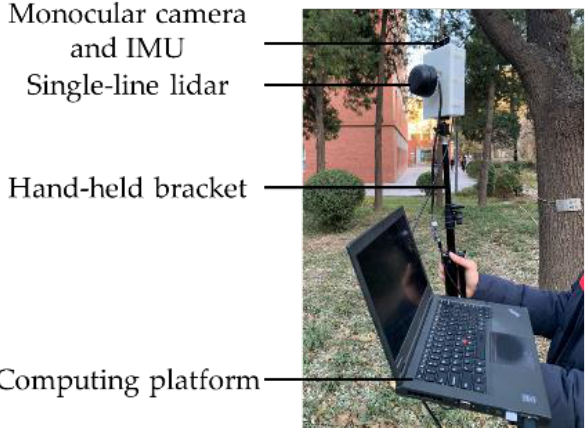
Figure 4. The 3D point cloud reconstruction system.